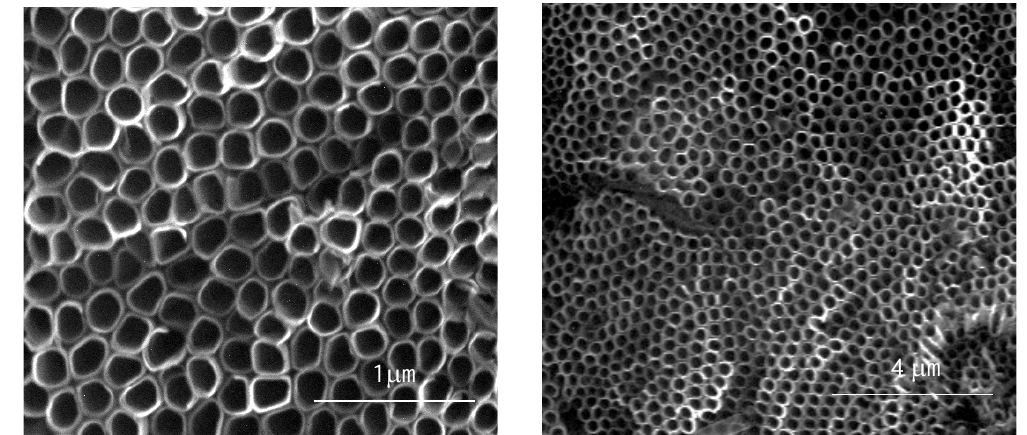
Figure 3. Titania nanotubes coating (TNT30) produced in ethylene glycol as a basis electrolyte, which contain 0.2 M hydrofluoric acid and 1 wt % of water, under the constant potential − 30 V.